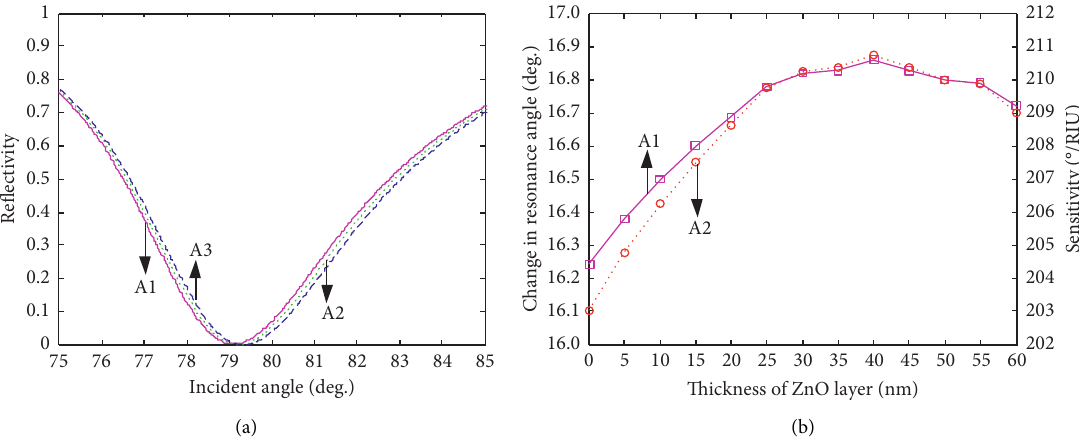
Figure 6: (a) SPR spectrum for different thickness of ZnO layer for d � 10nm (curves A1), 15 nm (curves A2), and 20nm (curves A3), as the case of n � 1.36 for sensing medium. (b) Relationship between the change in resonance angle (curves A1), sensitivity (curves A2), and the thickness of TiO 2 layers. The thickness is 15nm, 46nm, 1 × 0.65nm, and 3 × 1.6nm for TiO 2 , Au, MoS 2 , and GO layer, respectively.